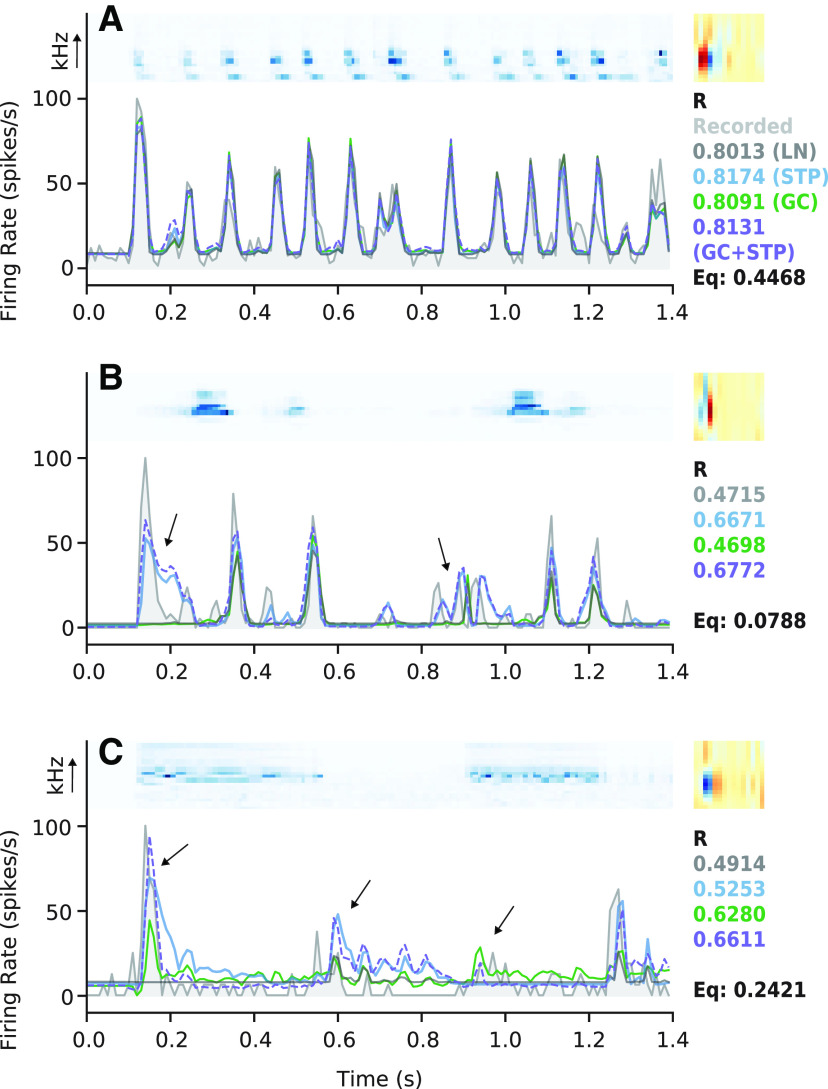
Example model fits and predictions. A, Results from a neuron for which the STP and GC model predictions were not significantly better than the LN model prediction. Top left subpanel, Spectrogram from one natural sound in the validation set. Top right panel, Spectro-temporal filter from the LN model fit (right). Bottom panel, Actual PSTH response (light gray, filled) overlaid with predictions by the LN (dark gray), STP (blue), GC (green), and GC+STP (purple, dashed) models. Values at the bottom right of each panel indicate the prediction correlations for each model in the corresponding color. Below this list is the cell’s equivalence score (black, see Fig. 4B). The actual response was smoothed using a 30-ms boxcar filter for visualization. B, Comparison for a neuron for which the STP model performed significantly better than the LN and GC models, plotted as in A. Arrows indicate times for which the STP model successfully reproduced an increase in firing rate while the other models did not. The combined model prediction closely follows the STP model prediction. C, Comparison for a neuron for which the GC model performed significantly better than the LN and STP models. Right-most arrow indicates a time when the GC model successfully predicted an increase in firing rate while the LN and STP models did not, while the combined model closely followed the GC model. Middle arrow indicates a time when the STP model incorrectly predicted an increase in firing rate, and the combined model nearly matched the STP model. Left-most arrow shows a time when the combined model prediction differed from both the STP and GC model predictions to more closely match a strong onset response.